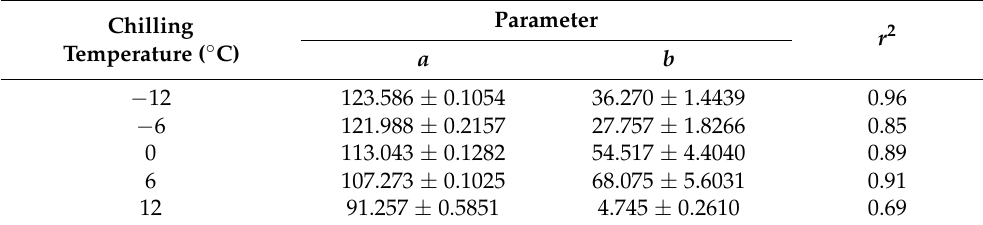
Figure 5. Cumulative distribution models for the development completion of Lymantria dispar asiatica eggs depending on different chilling treatments. Table 3. Estimated parameter values of development distribution model for Lymantria dispar asiatica eggs depending on chilling temperature.